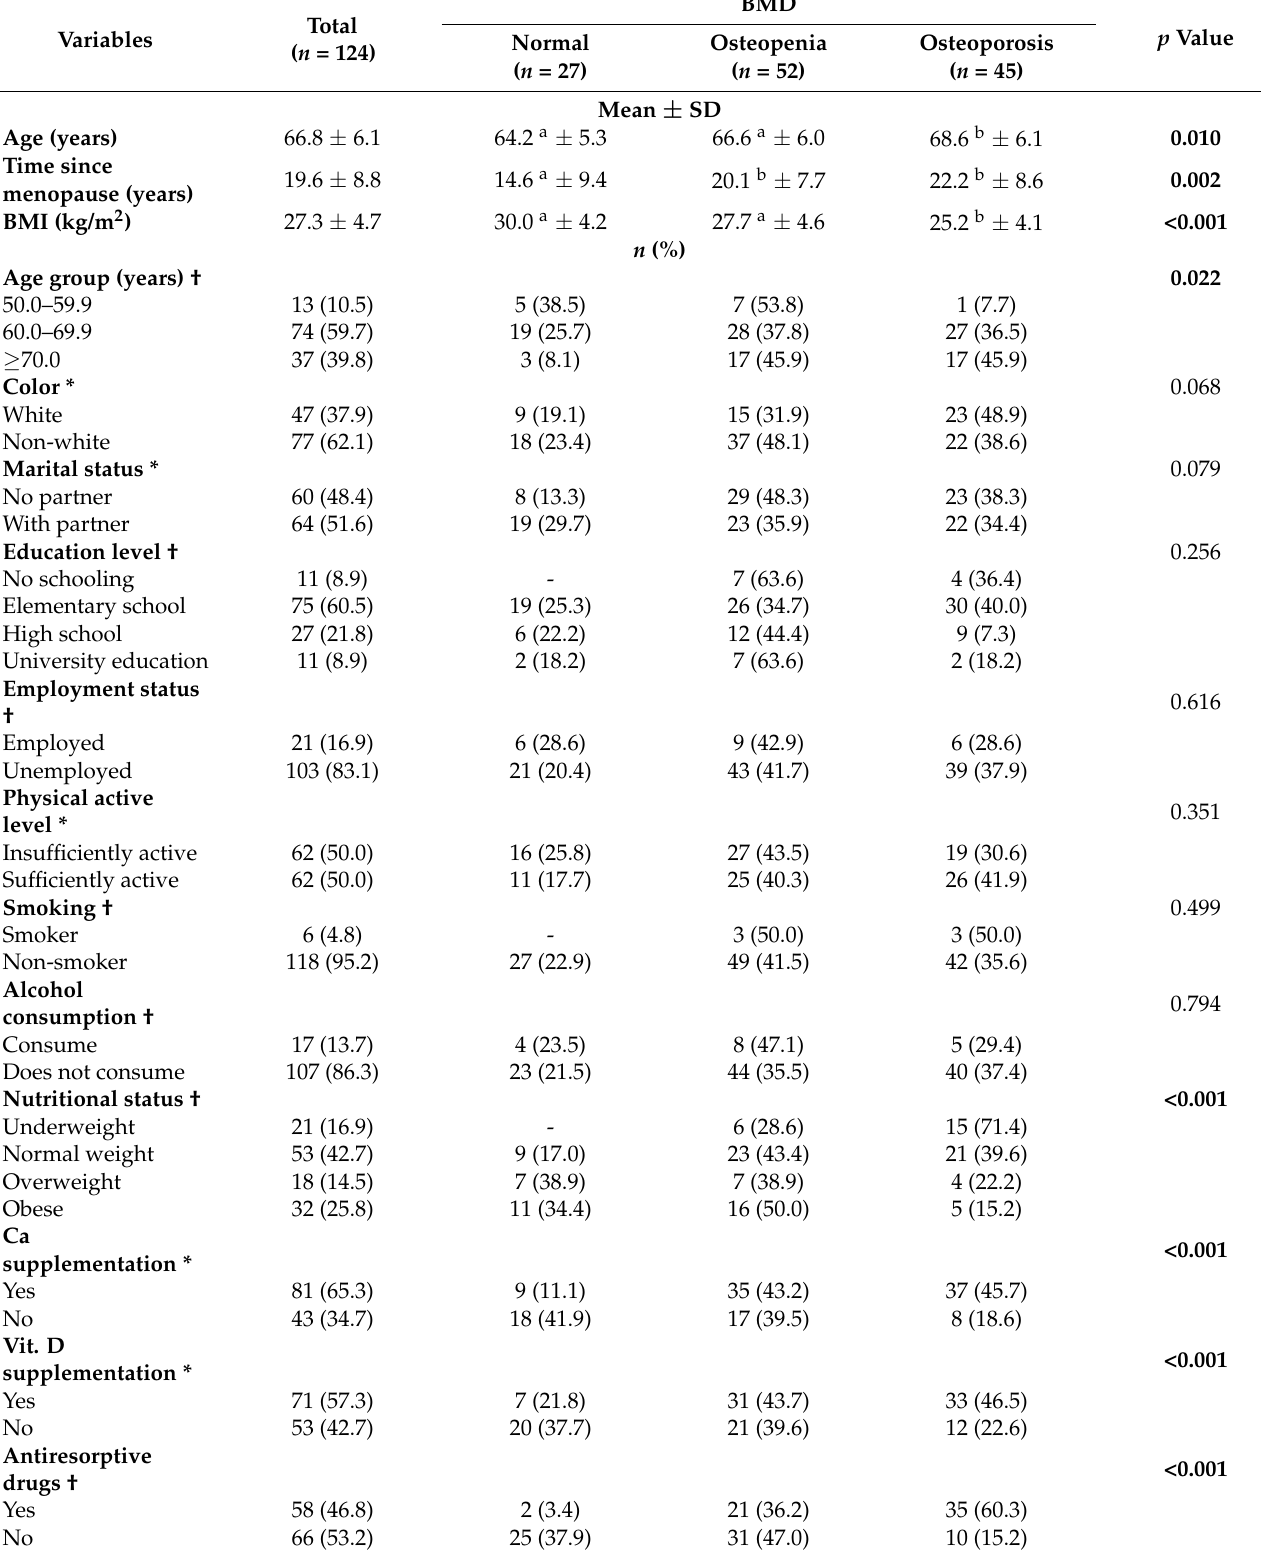
Table 1. Distribution of sociodemographic, lifestyle, and clinical variables according to bone mineral density categories in postmenopausal